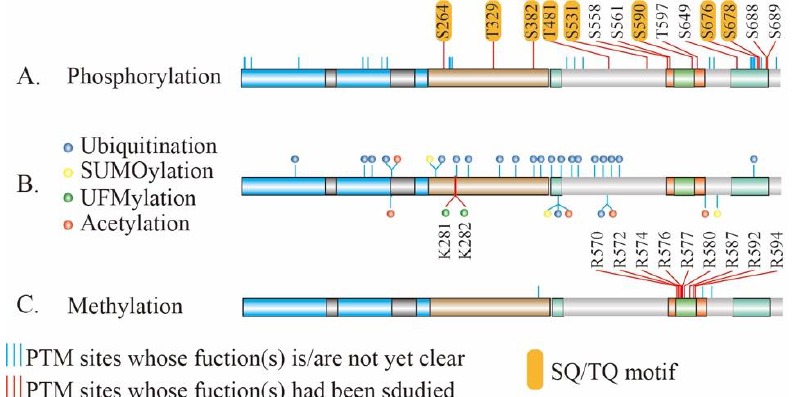
Figure 3. The PTMs sites on MRE11. The validated and potential PTM sites of MRE11. PTM sites with unclear function(s) are marked by blue line; PTM sites with validated functions are marked by the red line. The first bar shows phosphorylation sites of MRE11 ( A ); the middle one ubiquitination, SUMOylation, UFMylation, and acetylation of MRE11 are shown with blue-, yellow-, green-, and red-filled circles respectively ( B ); methylation PTM sites of MRE11 is shown in the third bar ( C ). SQ/TQ, Ser-Gln (SQ) and Thr-Gln (TQ).